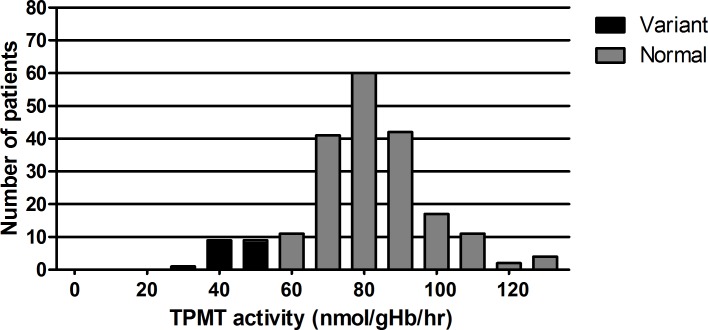
Distribution of TPMT activity.TPMT activity in nmol/gHb/hr for patients with normal (gray) and heterozygous (black) TPMT genotype.